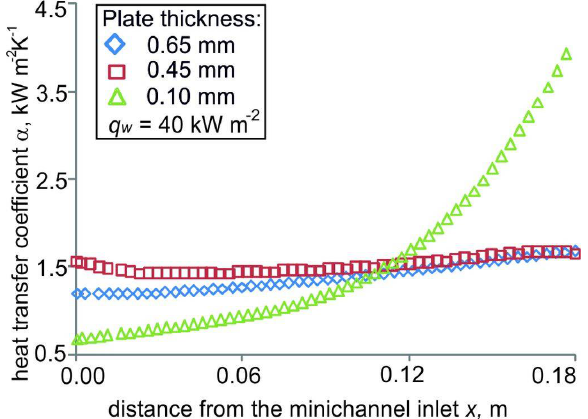
Fig. 7. Heat transfer coefficient vs. distance from the minichannel length obtained for the subcooled boiling region for three tested thicknesses of the heated plate, q w = 40 kW∙m -2